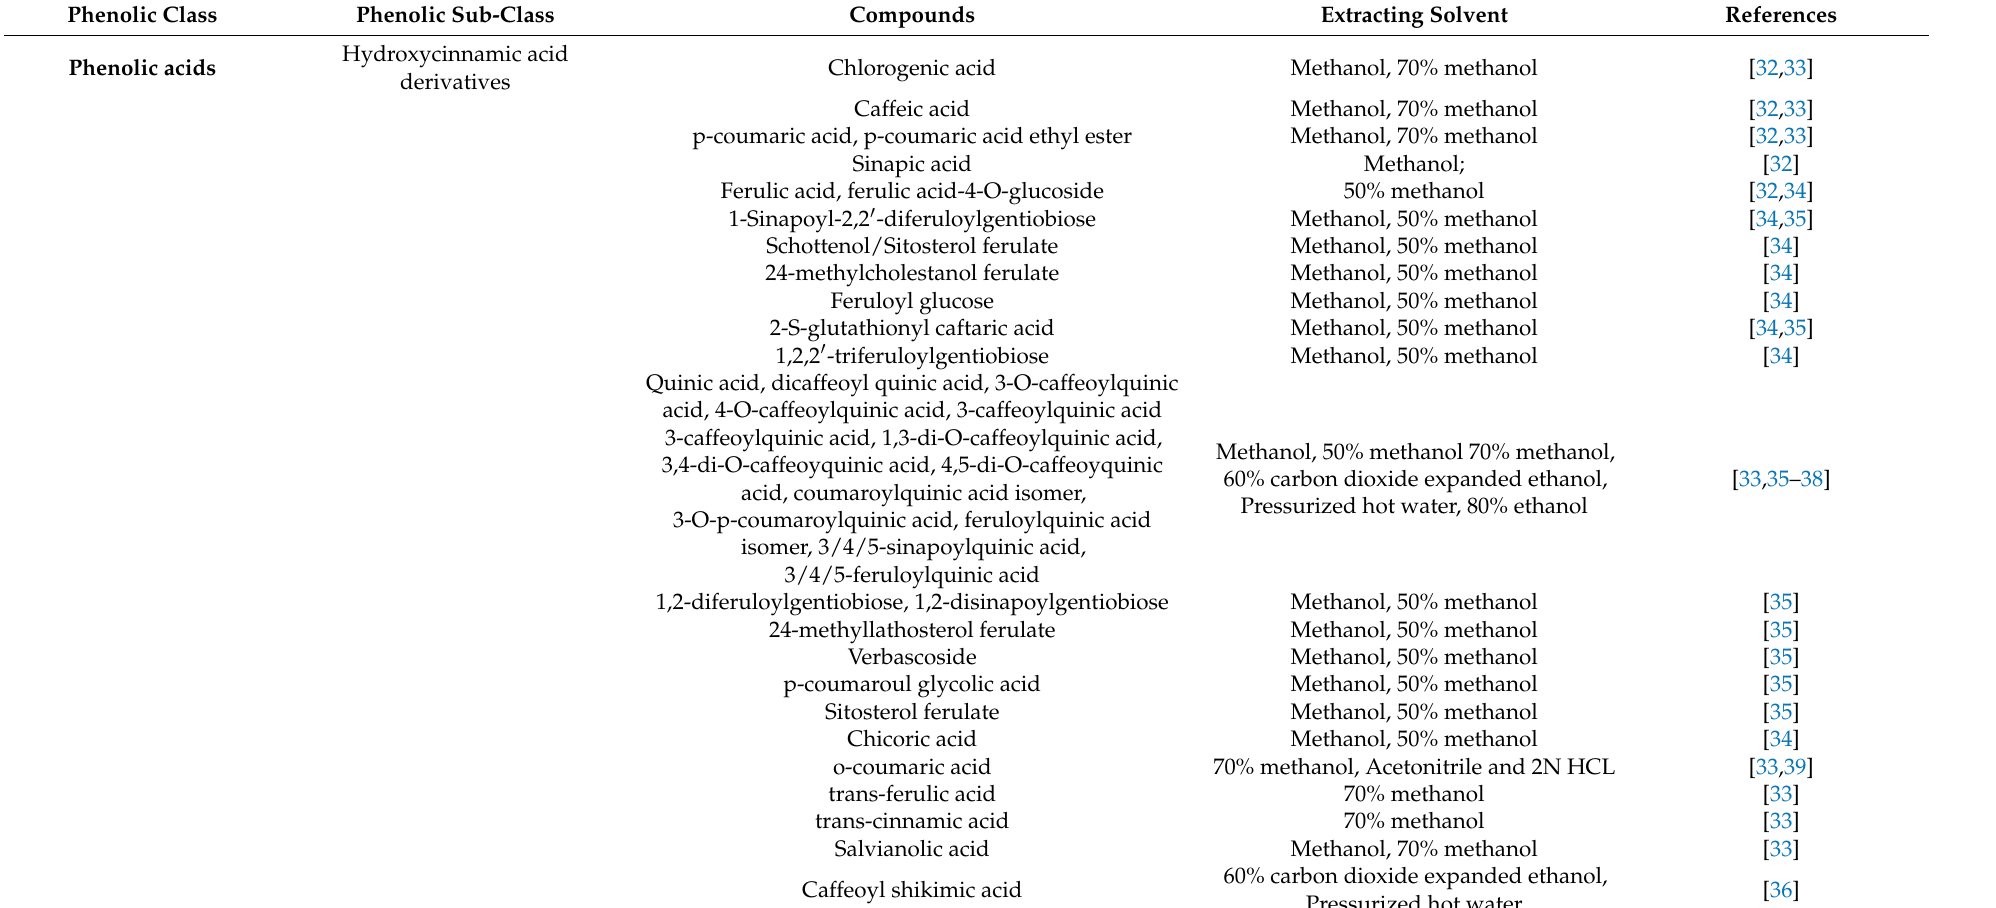
Table 2. Polyphenolic compounds isolated from Moringa oleifera